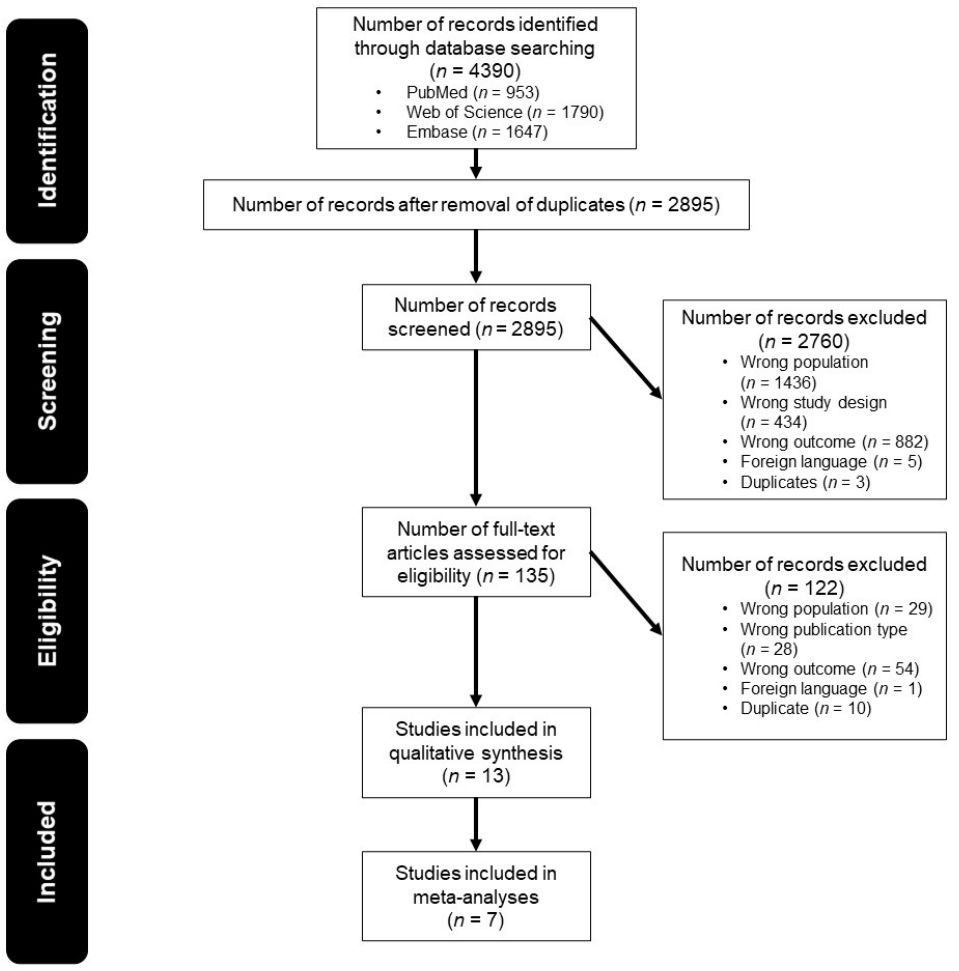
Figure 1. Flow diagram illustrating the study selection process.